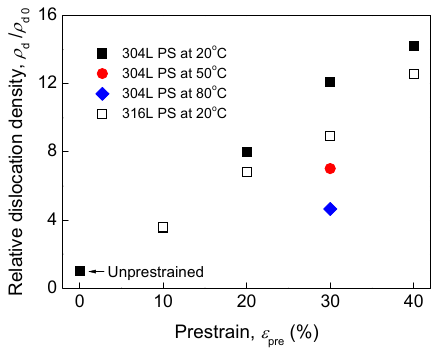
Figure 5. Relative dislocation density of un ‐ prestrained and prestrained (PS) specimens as functions of prestrain and temperature ( (cid:2025) (cid:2914)(cid:2868) : the dislocation density of un ‐ prestrained specimen).